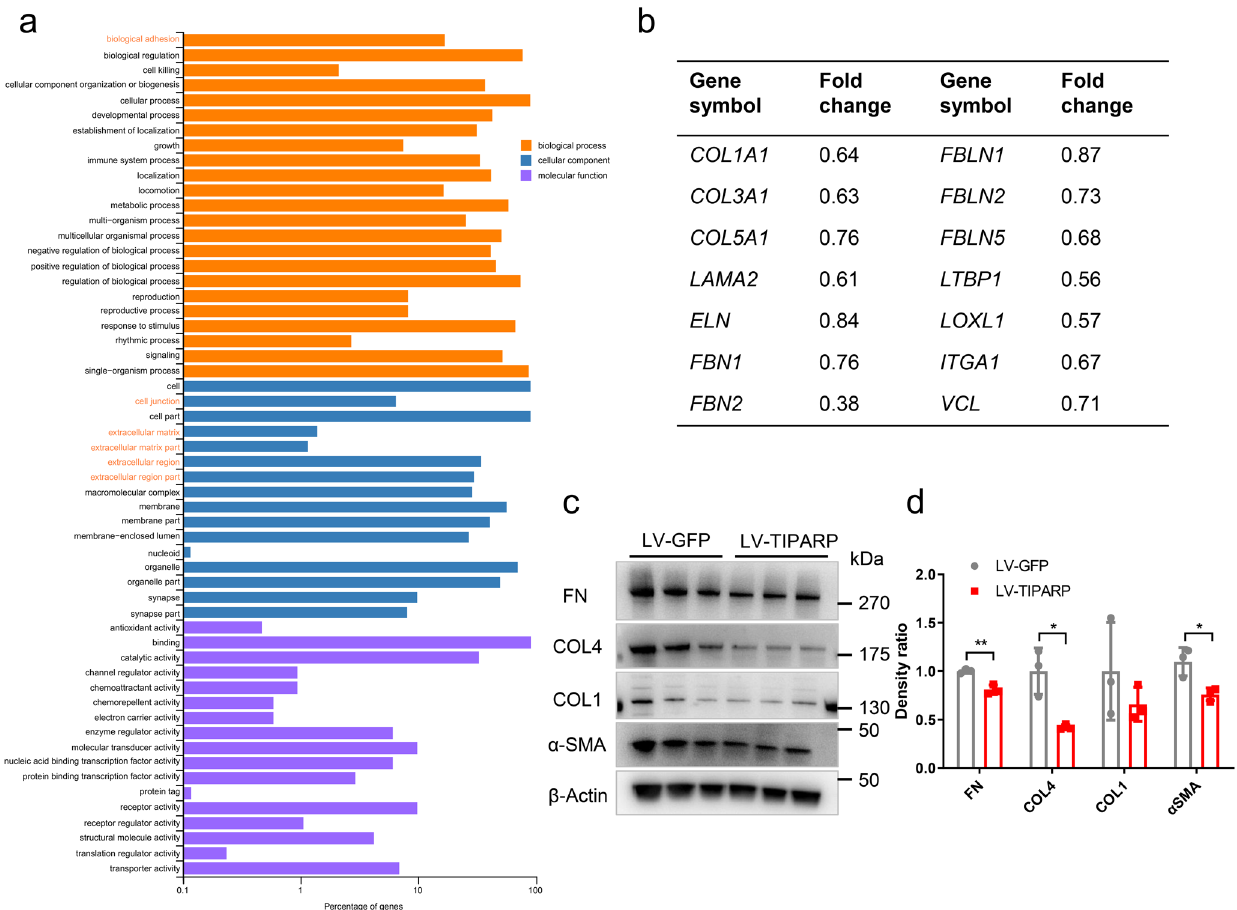
Fig. 4 Identi fi cation and veri fi cation of the expression of genes related to the conventional out fl ow function identi fi ed by the transcriptome data. a The differentially expressed mRNAs ( q value <0.05, fold changes >1.5 or <0.6) were classi fi ed by Gene Ontology terms. b Genes related to the conventional out fl ow function and its expression in transcriptome data. c , d Western blot and quantitative analyses showed fi bronectin, collagen type IV, and α -SMA expression decreased in the LV-TIPARP-treated HTM cells compared with the LV-GFP control cells ( n = 3, t test). Data are presented as the means ± standard deviations. * P < 0.05, ** P < 0.01. COL4 collagen type IV, COL1 collagen type I, FN fi